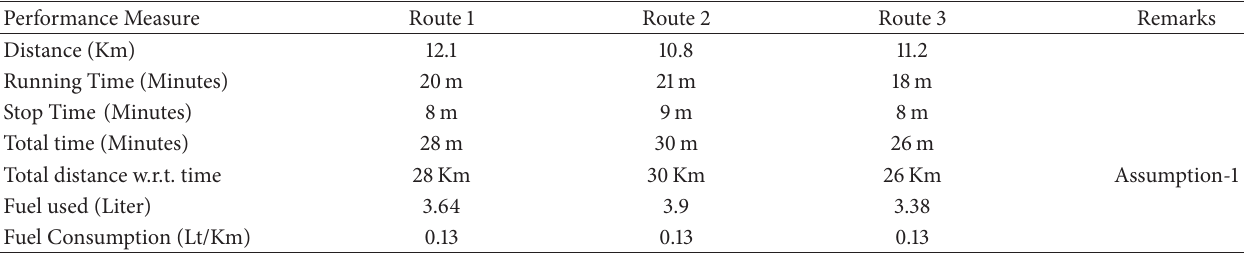
Table 5: Performance on heavy congested road